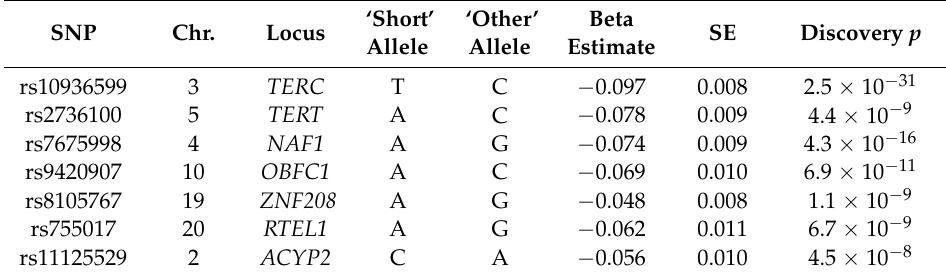
Table 1. Summarized data for the genetic variants associated with telomere length. SNP